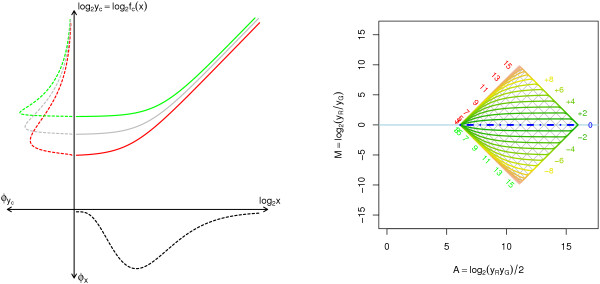
Equalizing the signal densities of the two channels removes the intensity dependency of the log-ratios for non-differentially expressed genes. Equalizing the signal densities of the two channels remove the intensity dependency of the log-ratios of non-differentially expressed genes. Left: Equal gene-expression distributions in both channels will under the non-channel balanced affine transform A1
MathType@MTEF@5@5@+=feaafiart1ev1aaatCvAUfeBSjuyZL2yd9gzLbvyNv2CaerbwvMCKfMBHbqedmvETj2BSbWenfgDOvwBHrxAJfwnHbqeg0uy0HwzTfgDPnwy1aqee0evGueE0jxyaibaieYdOi=BH8vipeYdI8qiW7rqqrFfpeea0xe9Lq=Jc9vqaqpepm0xbbG8FasPYRqj0=yi0lXdbba9pGe9qqFf0dXdHuk9fr=xfr=xfrpiWZqaaeaabiGaaiaacaqabeaadaqacqaaaOqaaGWaaiab=bq8bnaaBaaaleaatCvAUfKttLearCWrP9MDH5MBPbIqV92AaGqbaiab+fdaXaqabaaaaa@43C0@ turn into two different densities for the measured data. The (upside-down and dashed) curve at the bottom shows a hypothetical density function, φx(·), of the true (log) gene-expression levels expected to be equal in both samples. The distributions of the affine transformed signals are shown in the (rotated and dashed) density functions, {φyc(⋅)}c
MathType@MTEF@5@5@+=feaafiart1ev1aaatCvAUfKttLearuWrP9MDH5MBPbIqV92AaeXatLxBI9gBaebbnrfifHhDYfgasaacH8akY=wiFfYdH8Gipec8Eeeu0xXdbba9frFj0=OqFfea0dXdd9vqai=hGuQ8kuc9pgc9s8qqaq=dirpe0xb9q8qiLsFr0=vr0=vr0dc8meaabaqaciaacaGaaeqabaqabeGadaaakeaacqGG7bWEiiGacqWFgpGzdaWgaaWcbaGaemyEaK3aaSbaaWqaaiabdogaJbqabaaaleqaaOGaeiikaGIaeyyXICTaeiykaKIaeiyFa03aaSbaaSqaaiabdogaJbqabaaaaa@3A1B@, at the left (red and green curves). The average signal density (middle gray curve) to be normalized toward corresponds to a common measurement function (gray function in the main plot). Right: Normalizing the non-equal densities of the two channels makes the log-ratios of the non-differentially expressed genes zero for all intensities.